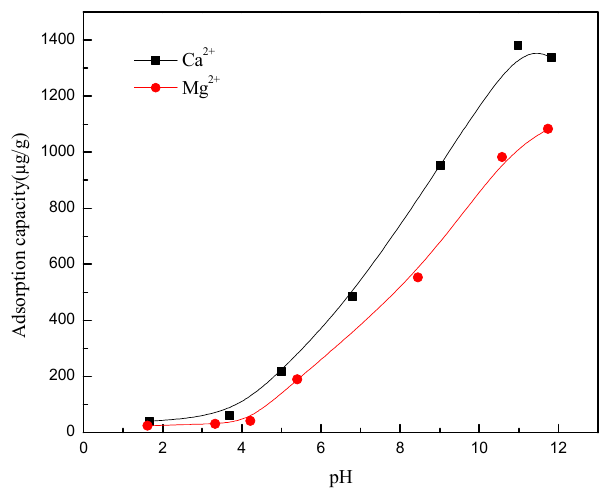
Figure 9. Adsorption capacity of Ca 2+ and Mg 2+ at different pH levels.